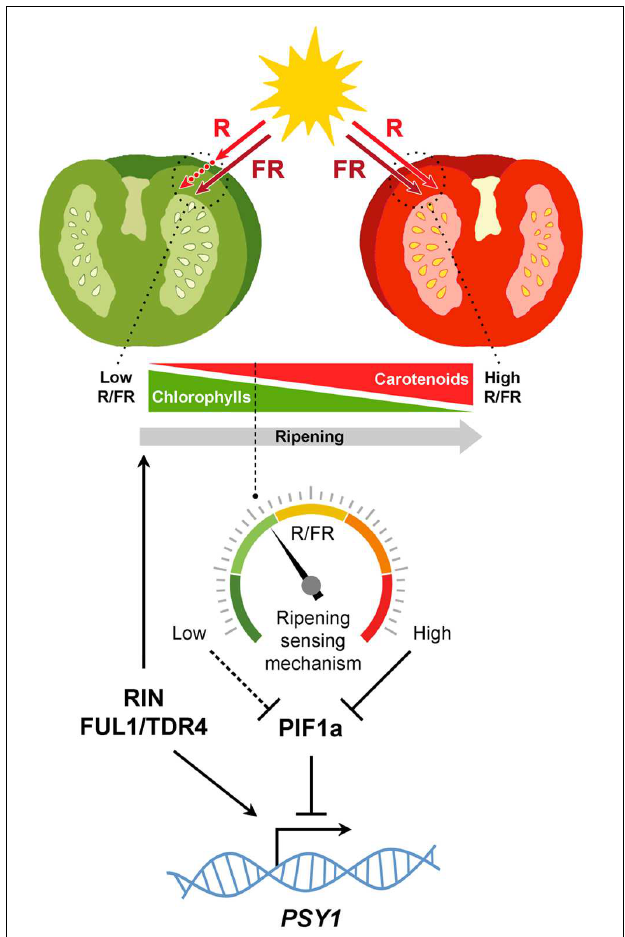
FIGURE 2 | Self-shading model for the light mediated modulation of carotenoid biosynthesis in tomato fruits. Chlorophylls in green fruits preferentially absorb red (R, ca. 660 nm) wavelengths of the light spectrum, generating a self-shading effect characterized by low R to far-red (FR, ca. 730 nm) ratios that maintain PHYs predominantly in the inactive form and relatively high levels of PIF1a repressing PSY1 . Once seeds mature, the developmental program induces the expression of genes encoding master activators of the ripening process. Some of them, like RIN and FUL1/TDR4, also induce PSY1 gene expression directly. Chlorophyll breakdown reduces the self-shading effect so that the R/FR ratio within the cells gradually increase, consequently displacing PHYs to their active form, reducing PIF1a levels and derepressing PSY1 expression. By sensing the spectral composition of the light filtered through the fruit pericarp, this mechanism diagnoses actual ripening progression to finely adjust fruit carotenoid